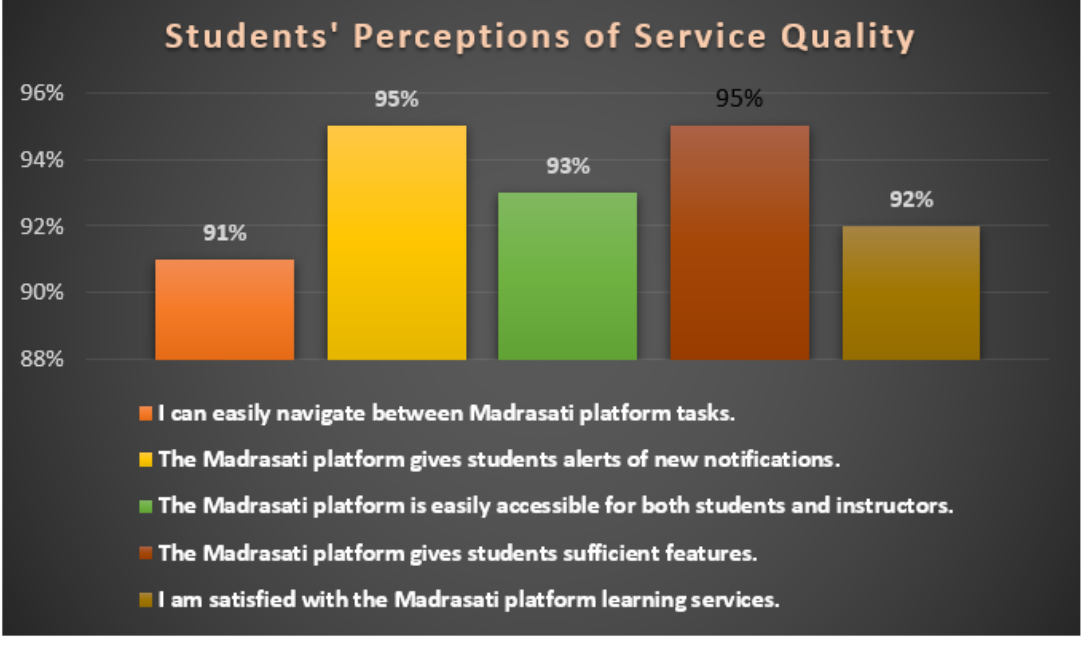
Figure 4. Students’ perceptions of SEQ of the Madrasati platform.